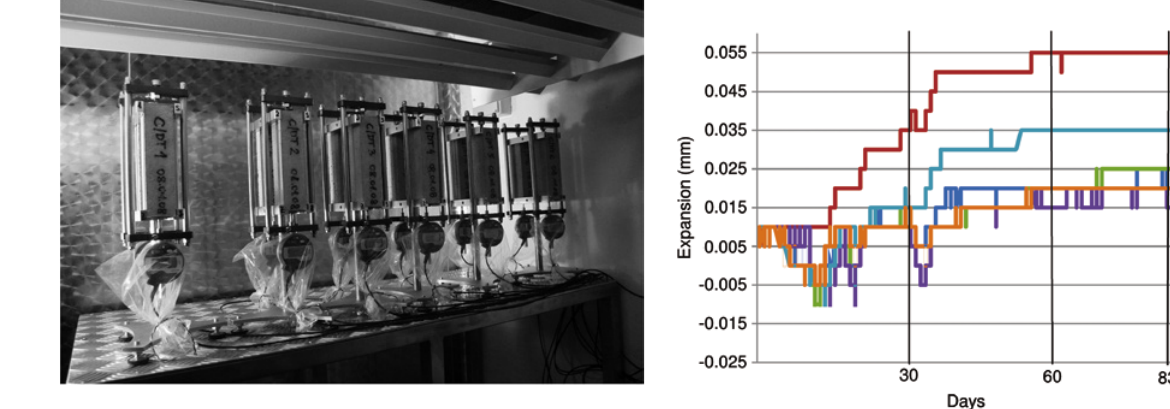
Figure 12 The results of expansion measurements for samples labelled CI-DT after the Duggan